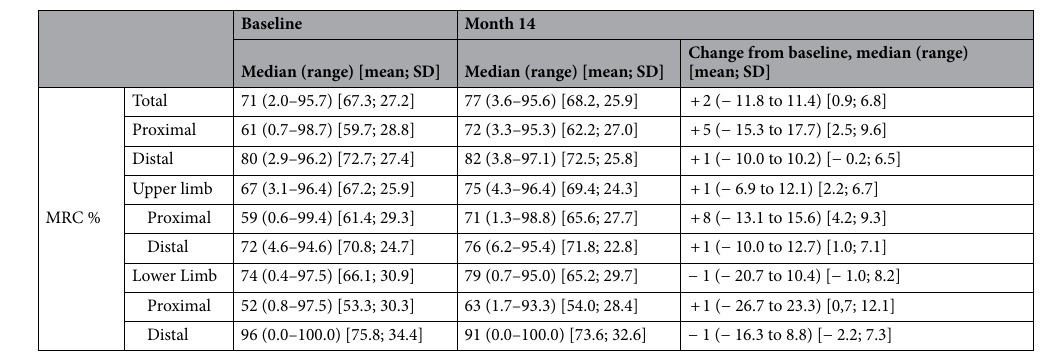
Table 2. Motor-function outcomes pre-treatment and at month 14 (n = 15). Change from baseline was calculated individually for every patient and is presented as the median change of all patients. MRC % Medical Research Council Scale %, SD standard